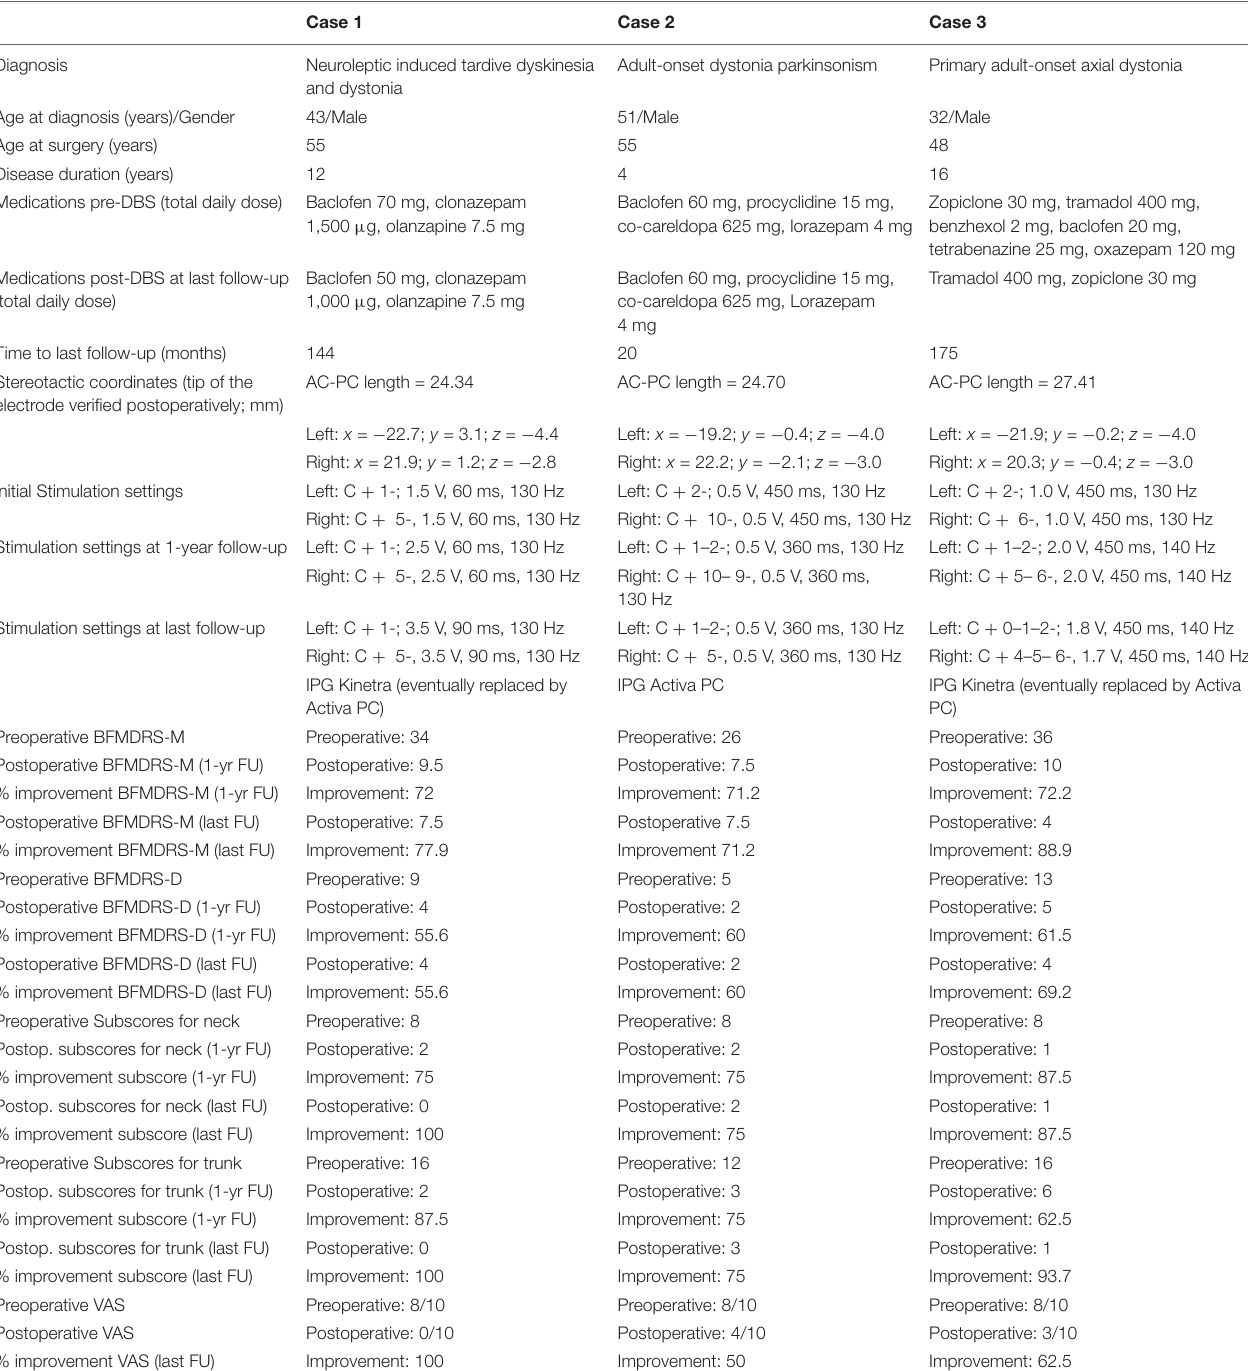
TABLE 1 | Patient features, stimulation settings, and